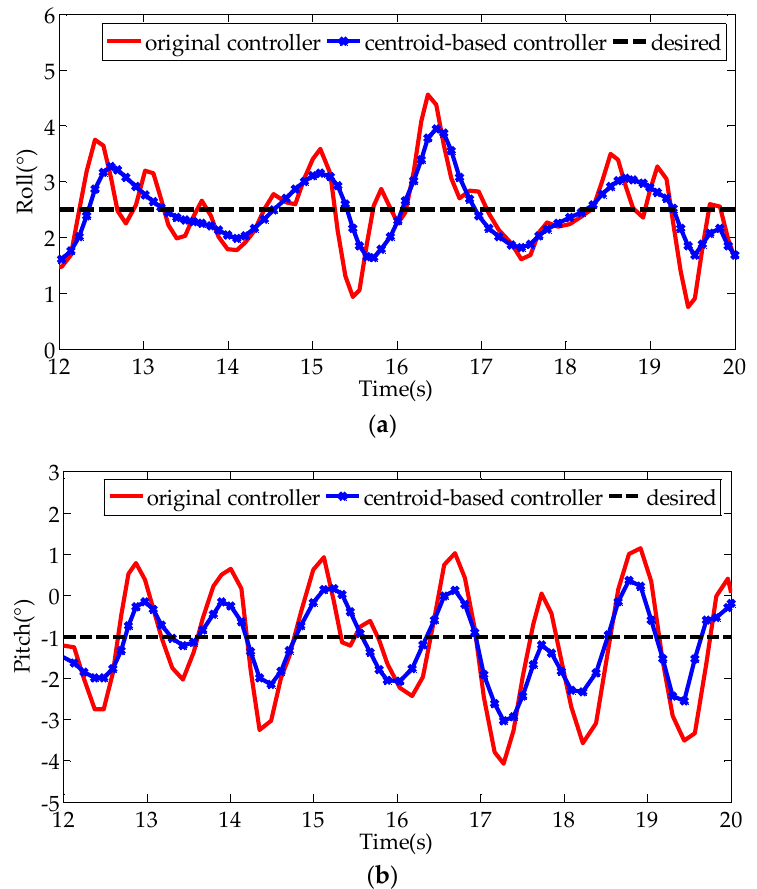
Figure 12. Attitude angle curves of the robot trunk. ( a ) Roll angle of the robot trunk. ( b ) Pitch angle of the robot trunk.